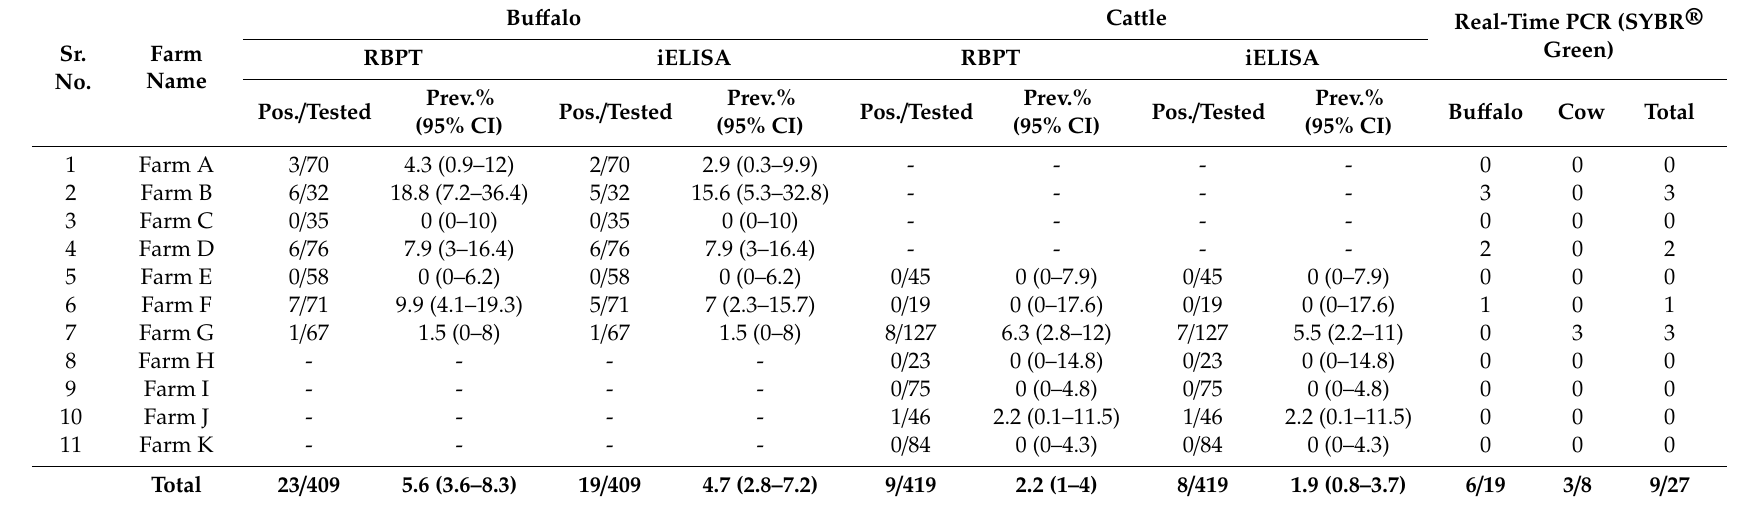
Table 1. Seroprevalence in cattle and bu ff aloes sampled from various